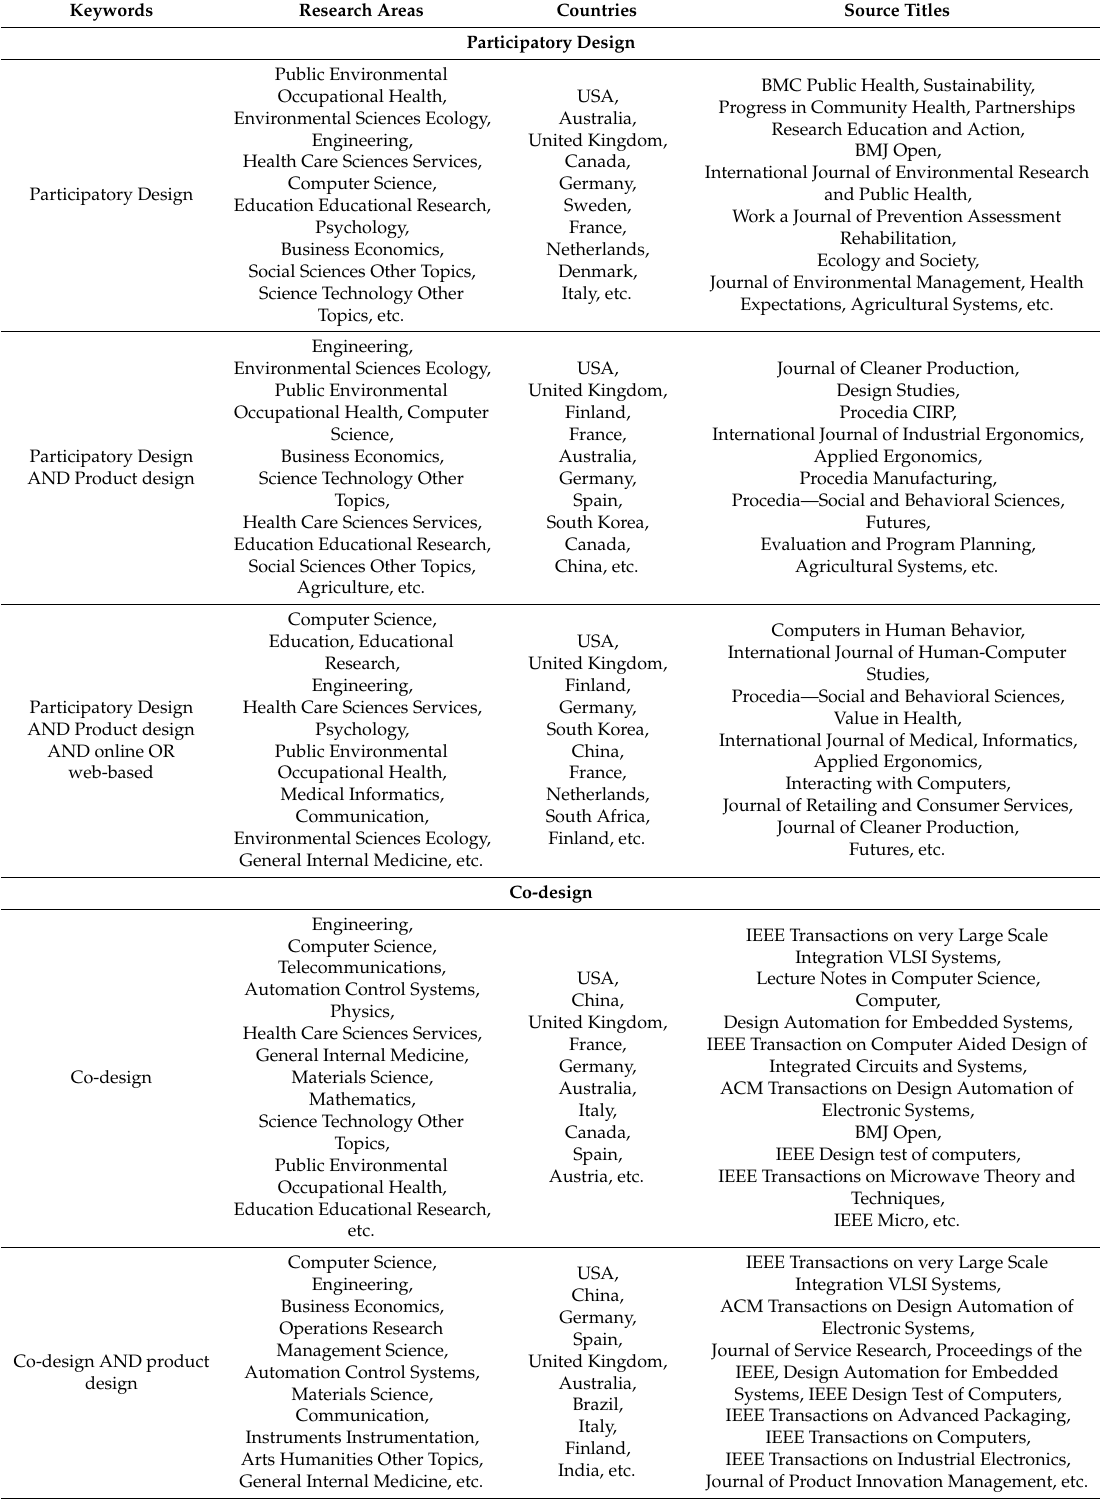
Table 3. Research area, country, and source publications of the literature that contains the keywords “participatory design”, “co-design”, and